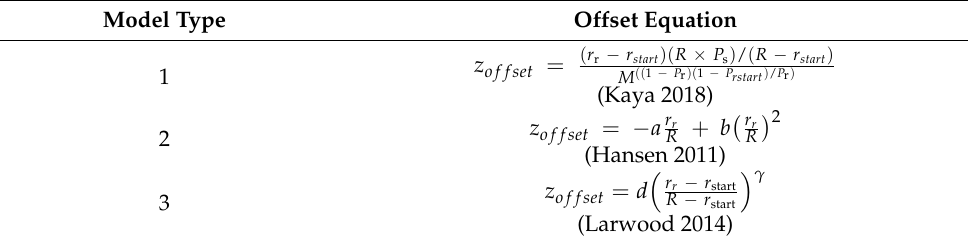
Table 2. Sweep offset equations for three